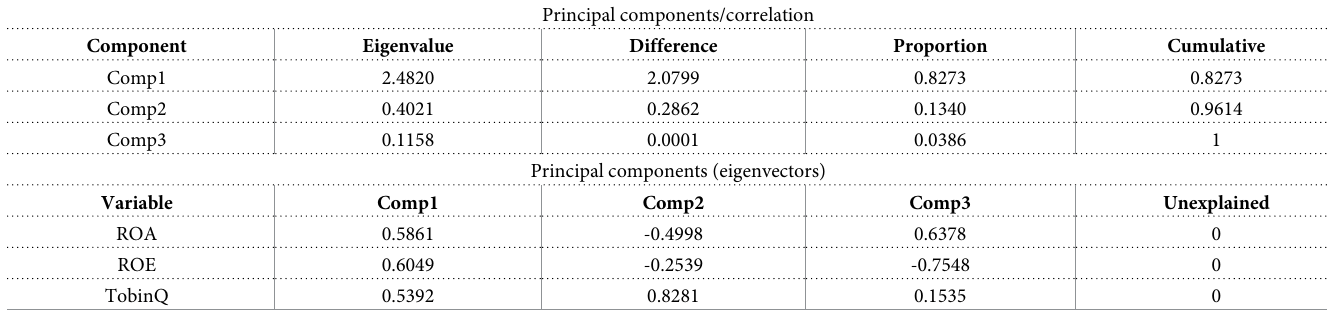
Table 4. Regression